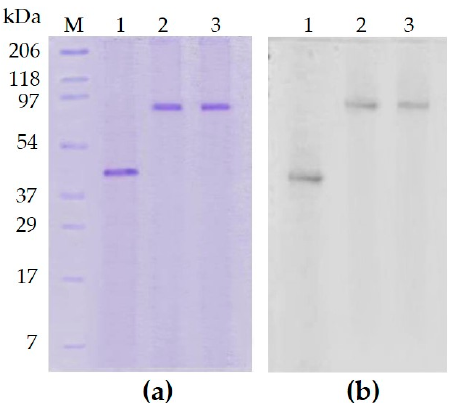
Figure 2. PARPSso dimerization in the presence of NAD + and ATP. ( a ) SDS-PAGE (12%) and staining in 0.1% Comassie brilliant blue R; ( b ) immunoblotting with anti-PARP antibody (Santa Cruz, rabbit anti-human PARP, H-250, 1:1000, v / v ). Incubation conditions in presence of NAD + and ATP are reported in § 2.4. Lanes: 1, purified PARPSso (20 µ g); 2, purified PARPSso (20 µ g) incubated in standard assay conditions for polymerase activity); 3, as in 2, in presence of 4 mM ATP. M, prestained molecular weight markers (Bio-Rad): myosin (206 kDa), beta-galactosidase (118 kDa), bovine serum albumin (97 kDa), ovalbumine (54 kDa), carbonic anhydrase (37 kDa), trypsin inhibitor (29 kDa), lysozyme (17 kDa), aprotinin (7 kDa). The experiment was carried out also on 0.4 mM compounds with similar results.